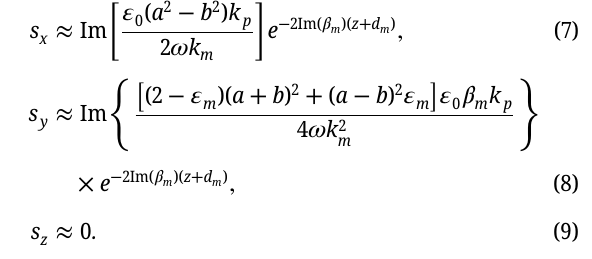
∞ s d r The spin AM of the SPP can be calculated by S = ∫ −∞ [36]. We plot the spin AM density of the SPP versus z for all three direction components under typical parameters in Figure 4. The spin density is not continuous on the chiral slab interfaces and agrees with the approximated results of Eqs. (7)–(9) very well. Since the x and y electric fields are phase synchronization, the z component spin AM den- sity is approximately equal to 0 for both symmetric and asymmetric modes. Meanwhile, the spin AM density has the same values on the two interfaces for the x component, i.e., the longitudinal spin, but the opposite values for the y component, i.e., the transverse spin. This means that the total transverse spin AM of the SPP vanishes. The nonzero longitudinal spin AM demonstrates that when a linearly polarized incident field couples to the mode, the reradiated field can carry the spin feature of the SPP. In the metal, the spin AM density decays away from the chiral slab with an exponential rate two times larger than that of the electric field. Compared to a TM-polarized SPP with plasmonic wave number k p , the y component spin AM density has the con- tribution from magnetic field.